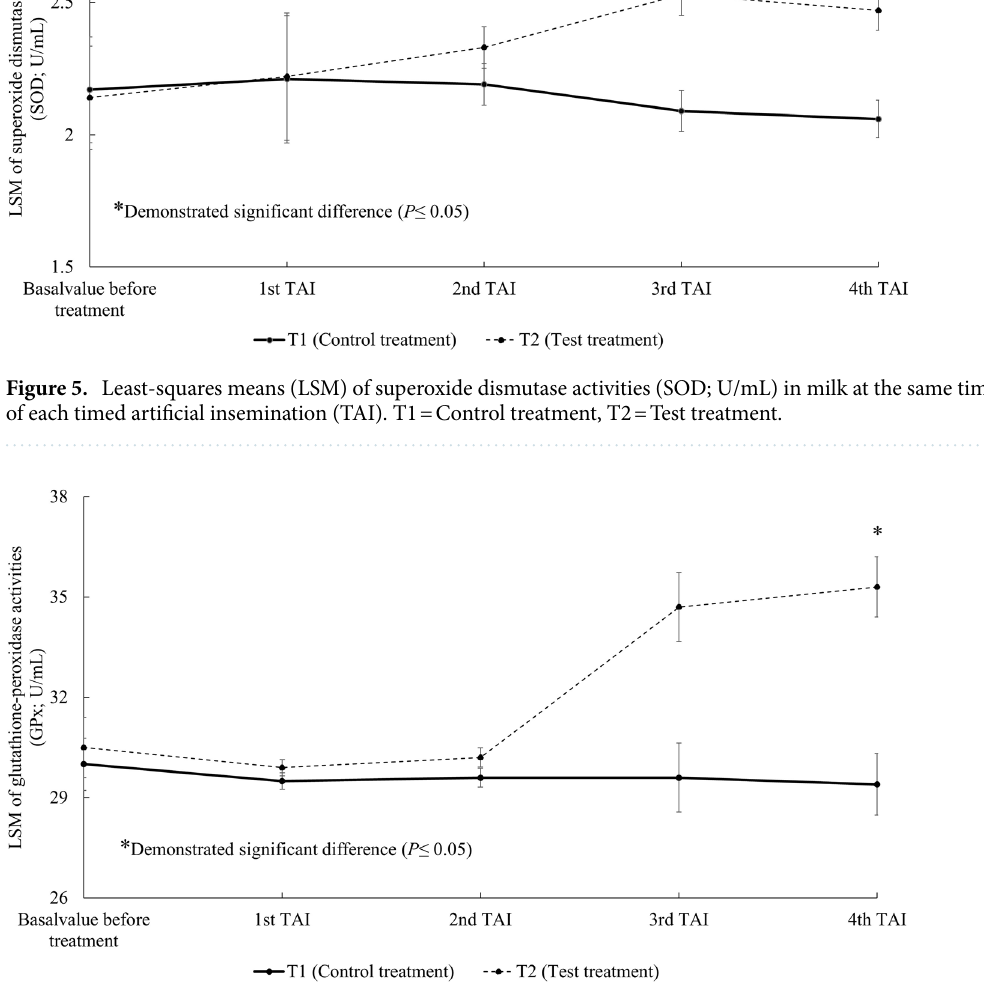
Figure 6. Least-squares means (LSM) of glutathione-peroxidase activities (GPx; U/mL) in milk at the same time of each timed artificial insemination (TAI). T1 = Control treatment, T2 = Test